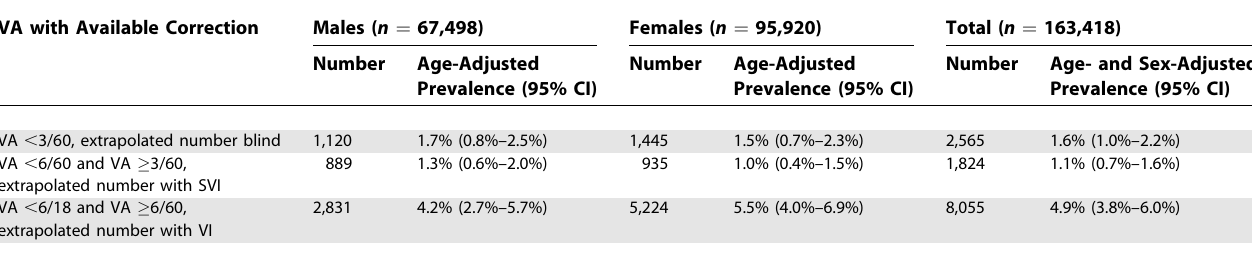
Table 6. Distribution by Visual Acuity with Available Correction in the Better Eye in Adults Aged 50 Years and Older VA with Available